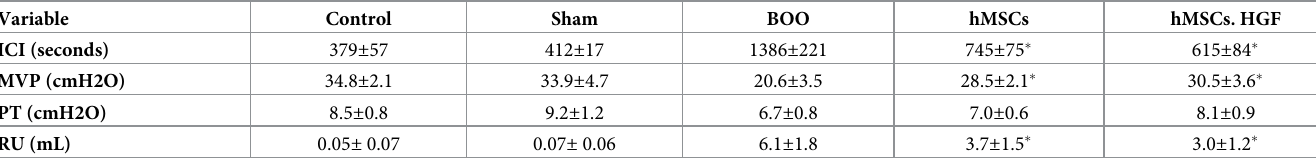
Table 2. Recovery of bladder contractility after transplantation.